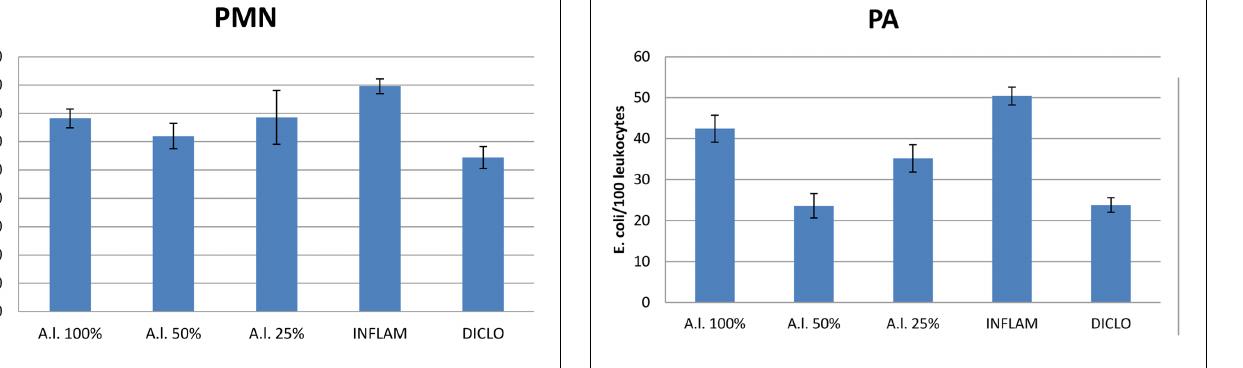
FIGURE 5 | Phagocytic activity (PA) of A. laxmannii extract. A.l. 100% – the animals received 5 mL/kg BW A. laxmannii ethanol extract 100% (100 mg dw/mL), A.l. 50% – the animals received 5 mL/kg BW A. laxmannii ethanol extract 50% (50 mg dw/mL), A.l. 25% – the animals received 5 mL/kg BW A. laxmannii ethanol extract 25% (25 mg dw/mL), Inflam – Inflammation was induced by i.m. injection of turpentine oil (6 mL/kg BW), Diclo – the animals received 20 mg/kg BW diclofenac ( p < 0.001).